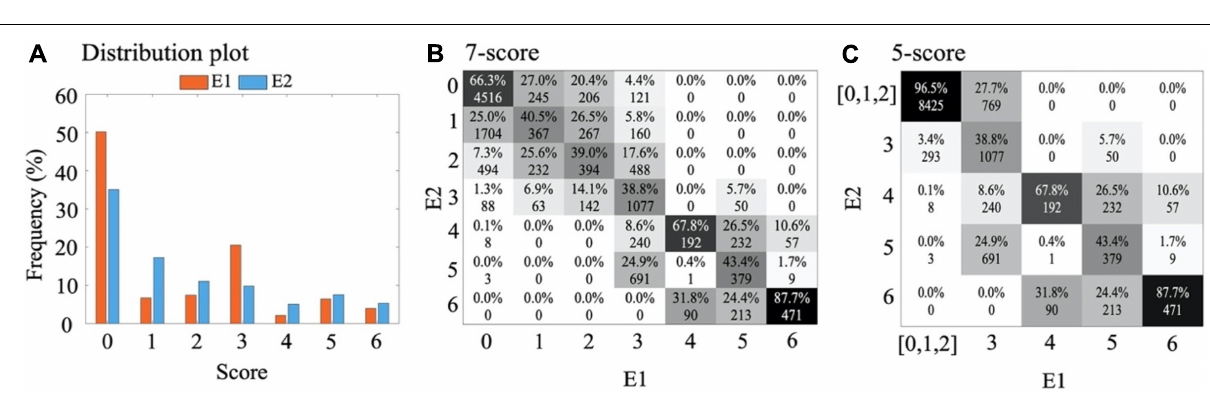
FIGURE 2 | Representative example epochs of the seven scores in the visual EEG background classification.